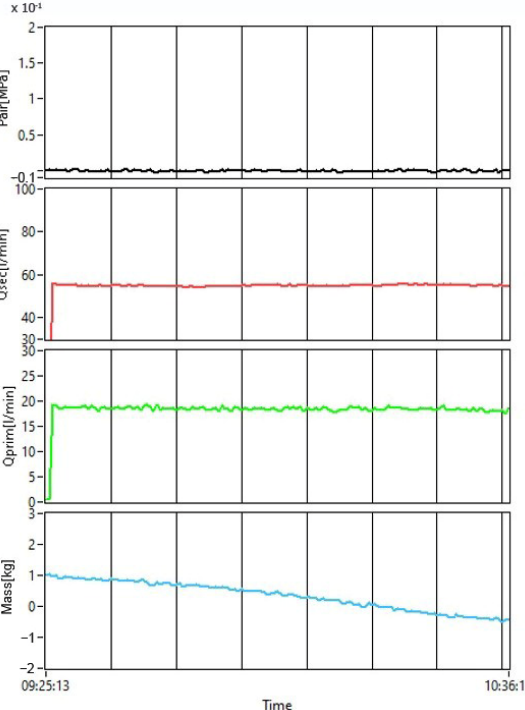
Figure 7. Evolution of pressure, primary and secondary air flow rate, and pellet consumption during the test with primary/secondary air flow rate ratio of 19/56 L/min.